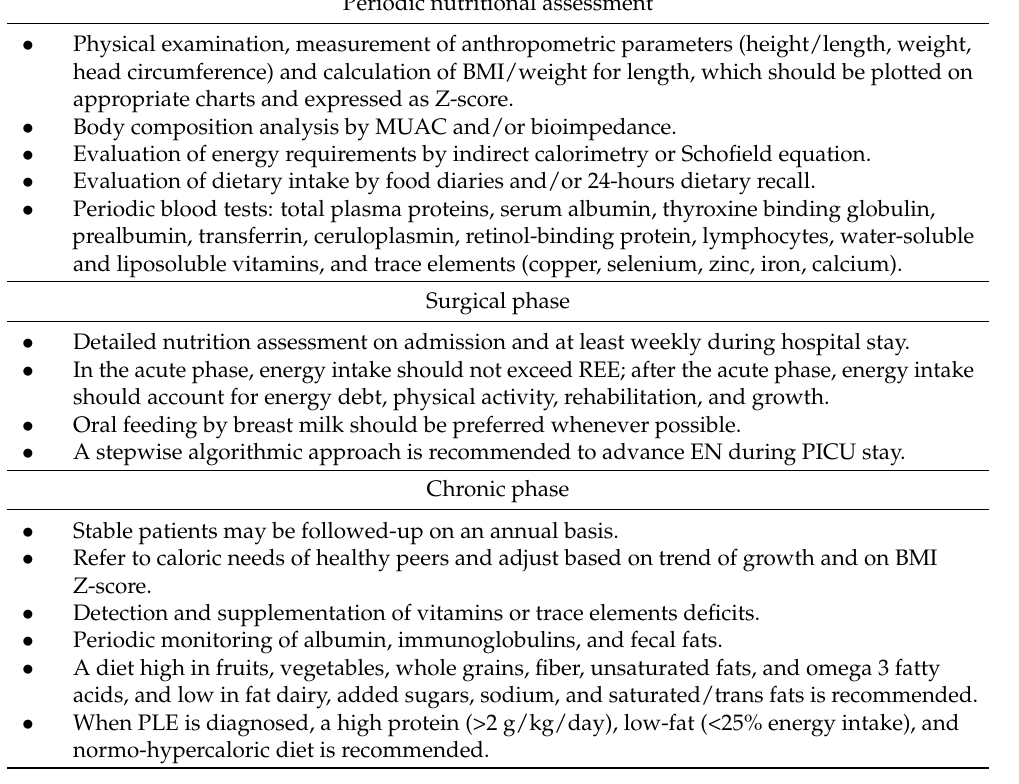
Table 1. Key points of nutritional interventions in patients with Fontan circulation. REE (resting energy